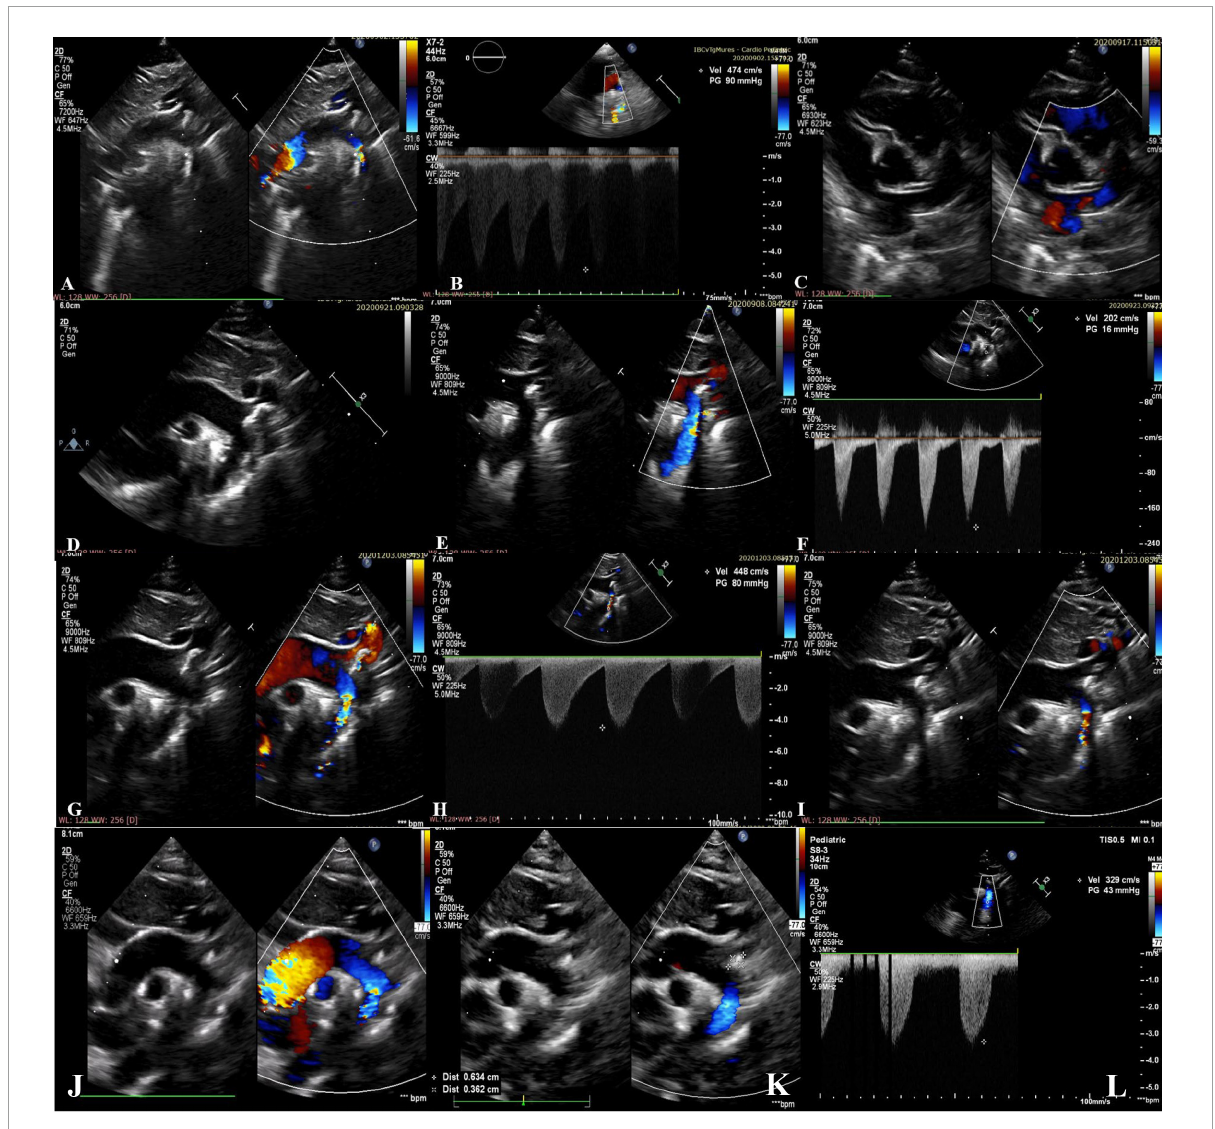
FIGURE1 (A–C) Preoperative echocardiographic images from the neonatal period showing hyperechogenicity and severe narrowing of the aortic arch with a 2.5 mm diameter of the descending aorta lumen (gradient of 90mmHg) and normal coronary arteries; (D–F) postoperative echocardiographic images from the neonatal period showing the brightness and the abnormal echogenicity of the walls of the aortic arch and descending aorta and calcified residual masses at the level of the aortic arch extended to the brachiocephalic trunk, left common carotid artery, left subclavian artery, with laminar color Doppler flow in the descending aorta. Diameter of descending aorta lumen of 5.5 mm; (G–I) echocardiographic images at 3 months of age showing re-coarctation of the aorta with a significant gradient and the persistence of the aortic arch calcifications; (J–L) echocardiographic images at 18-months of age showing the regression of the aortic arch calcifications without obstruction, and mild left ventricular